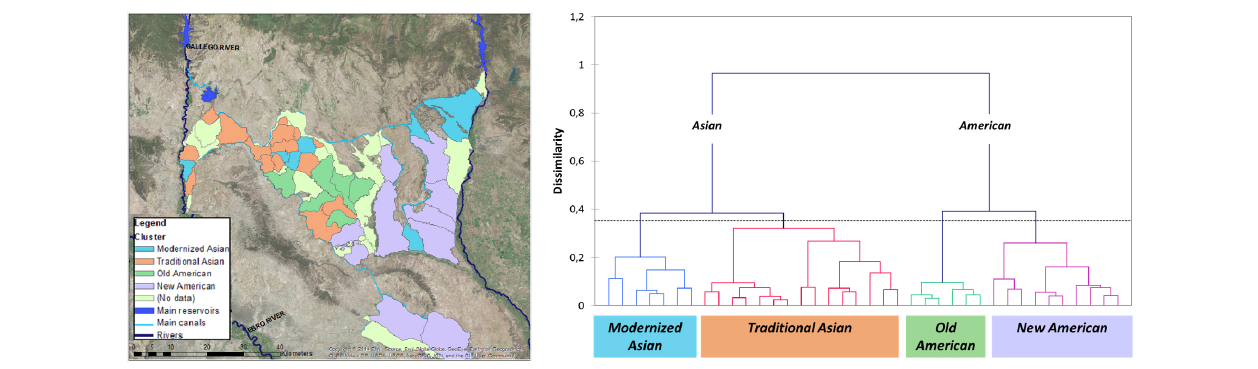
Fig. 1 . Map and dendrogram showing the spatial distribution of the water user associations (WUA) and the clusters obtained through the hierarchical cluster analysis